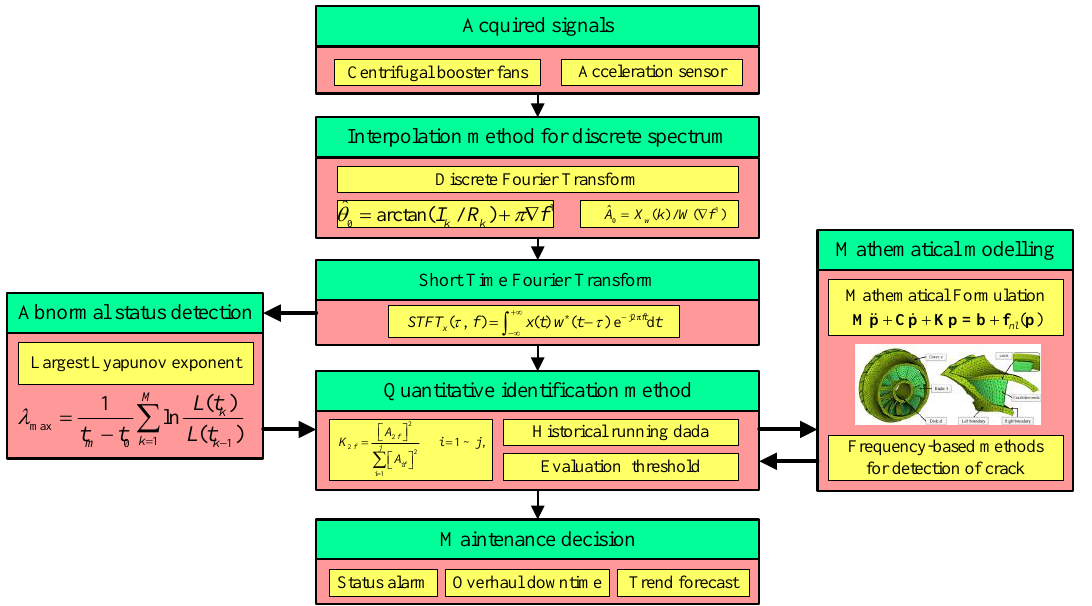
Figure 2. The work flow diagram of the research framework.